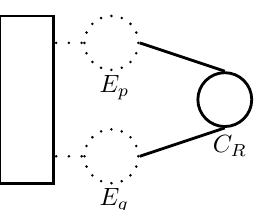
Figure 9. Conjugate-G-strings. A D3-brane wrapped on this cycle C R is the same BPS state as the D3-brane wrapped on the previous C G -cycle. The global structure is di(cid:11)erent from the previous one because the two E-strings, instead of E 0 -strings can be attached to ful(cid:12)ll the SCFT block